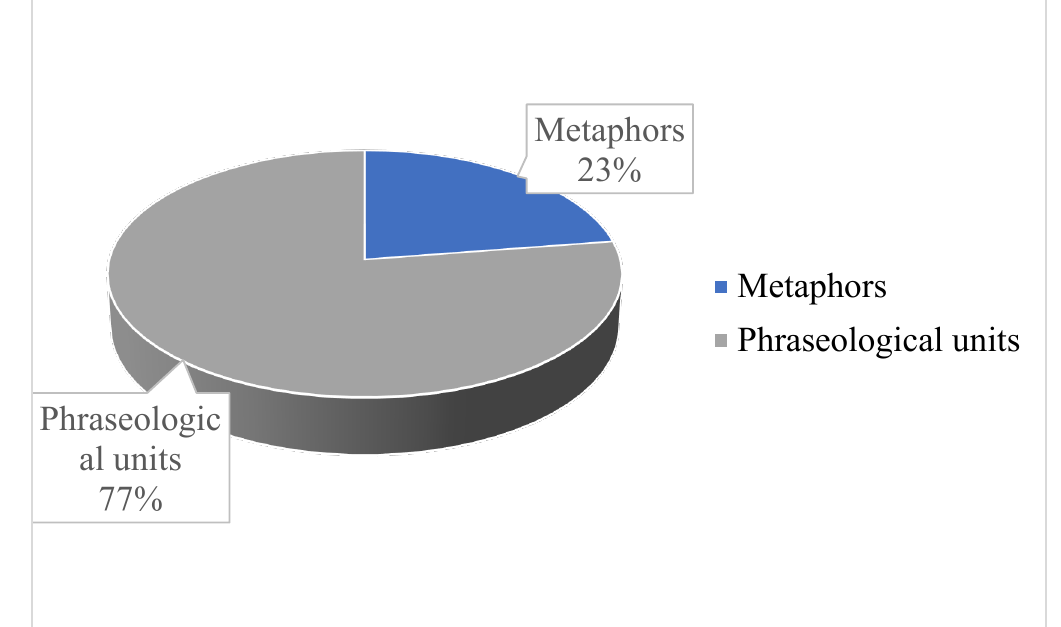
Figure 2 – Semantic relations ratio in the